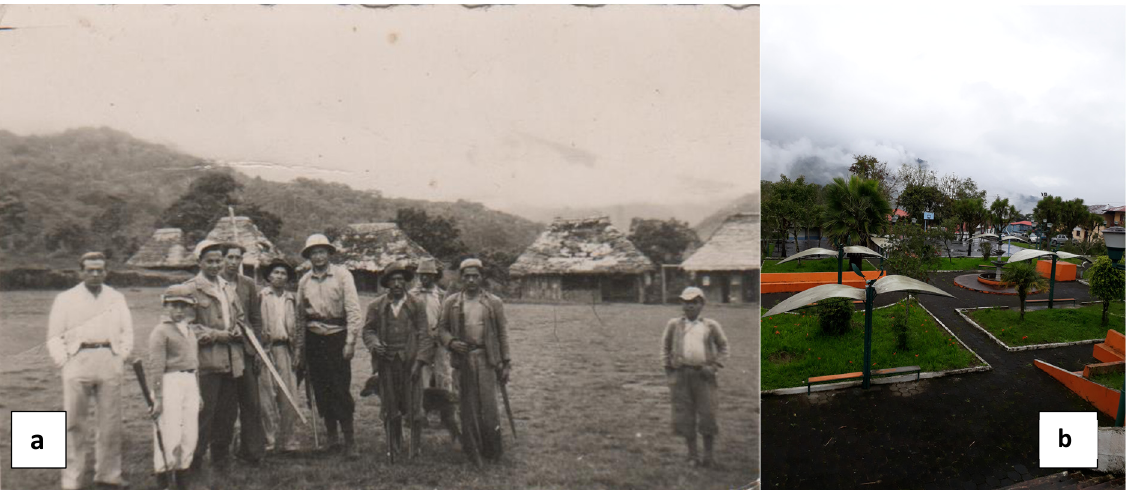
Figure 5. The left picture ( a ) shows the settlers and explorers in the central plaza of the old town of Baeza in 1950. Note the bare terrain and the huts as housing. On the right ( b ), the new plaza in 2020 with distinctive benches, electric posts, many trees, manicured gardens, paved roads, and traffic on the side road. Source ( a ) from Jack Rodríguez, Mar 1952. Source ( b ) from Jack Rodríguez, 22 Sep- tember 2021.